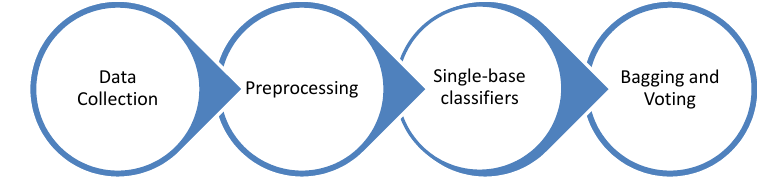
Fig 1: Data processing and modelling scheme